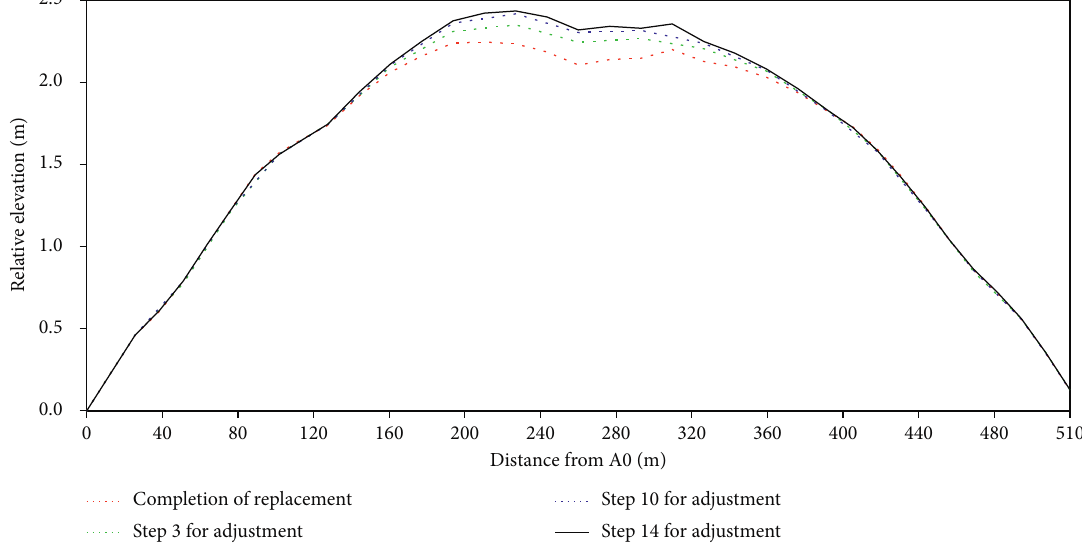
Figure 16: Variation in bridge deck profile with construction sequence for cable adjustment.